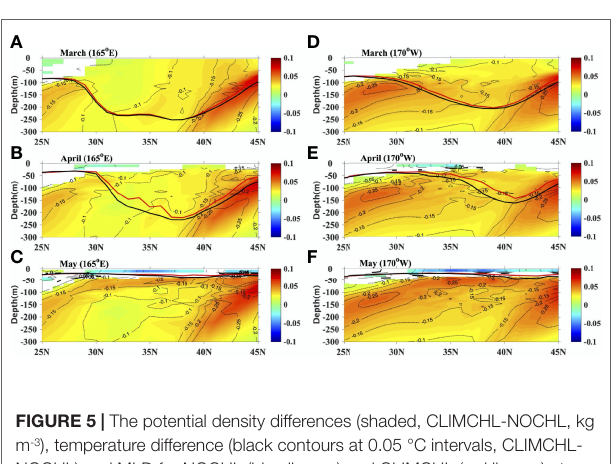
FIGURE 5 | The potential density differences (shaded, CLIMCHL-NOCHL, kg m -3 ), temperature difference (black contours at 0.05 °C intervals, CLIMCHL- NOCHL) and MLD for NOCHL (blue line, m) and CLIMCHL (red line, m) at 165°E in (A) March, (B) April and (C) May. (D–F) are the same as (A–C) but for 170°W. Only the potential density differences that are statistically significant are shown (95% significant level).